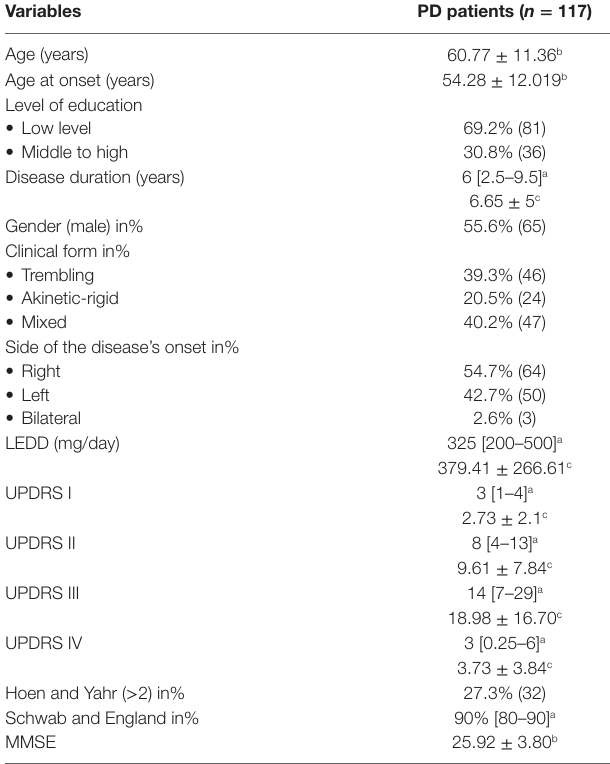
TaBle 1 | Characteristics of Moroccan Parkinson’s disease (PD)